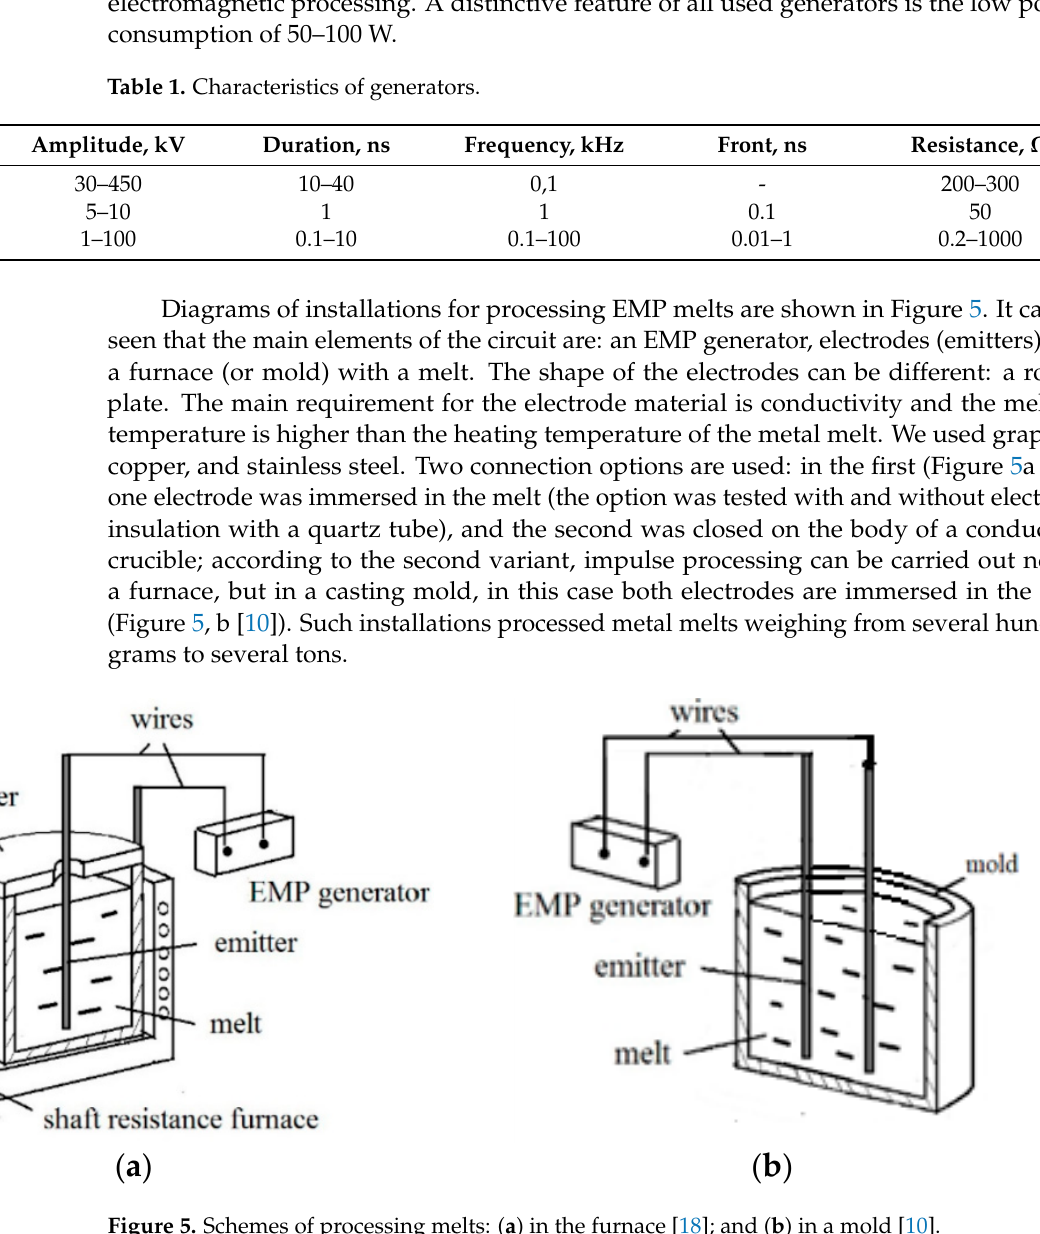
Figure 6. Scheme of treatment of the metal melt with EMP: 1—crucible, 2—melt, 3—alundum tip, 4—electrodes, 5—EMP generator, 6—“Paraboloid-4” installation [11]. The IYaF generator was used for processing (see Table 1). The metal temperature was recorded using a tungsten–rhenium thermocouple brand VR5/VR 20 [11]. Based on the obtained polytherms of the intensity of gamma-penetrating radiation, the critical points of phase and structural transformations, volumetric changes and thermal compression coefficients of the investigated metals and alloys in liquid, liquid–solid and solid states